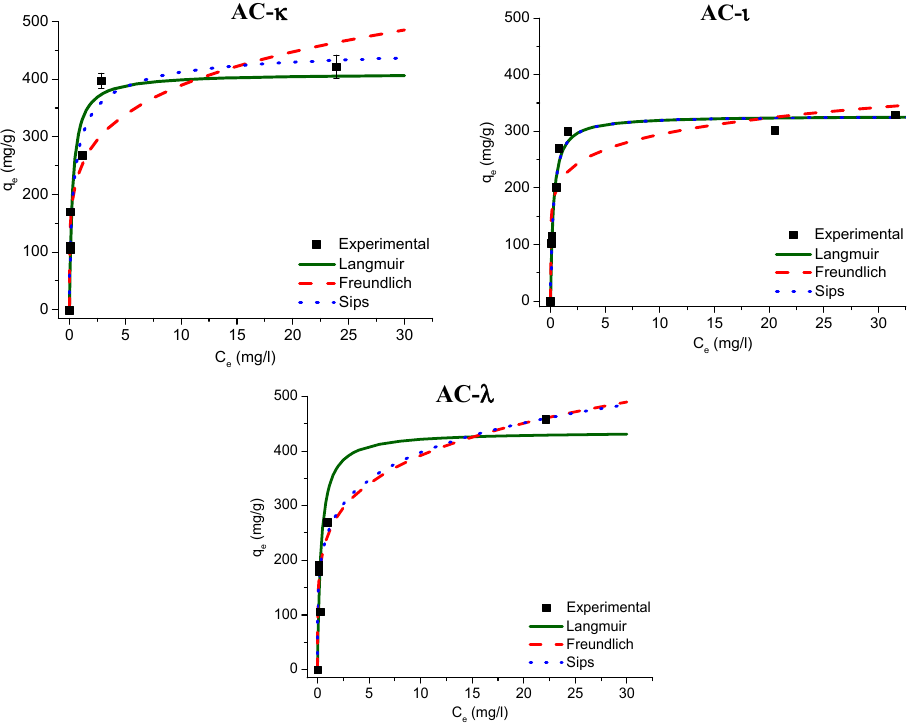
Figure 9. Isotherm data and the corresponding model fitting for the adsorption of ciprofloxacin on the activated carbons. Table 3. Equilibrium model parameters and goodness of fittings.